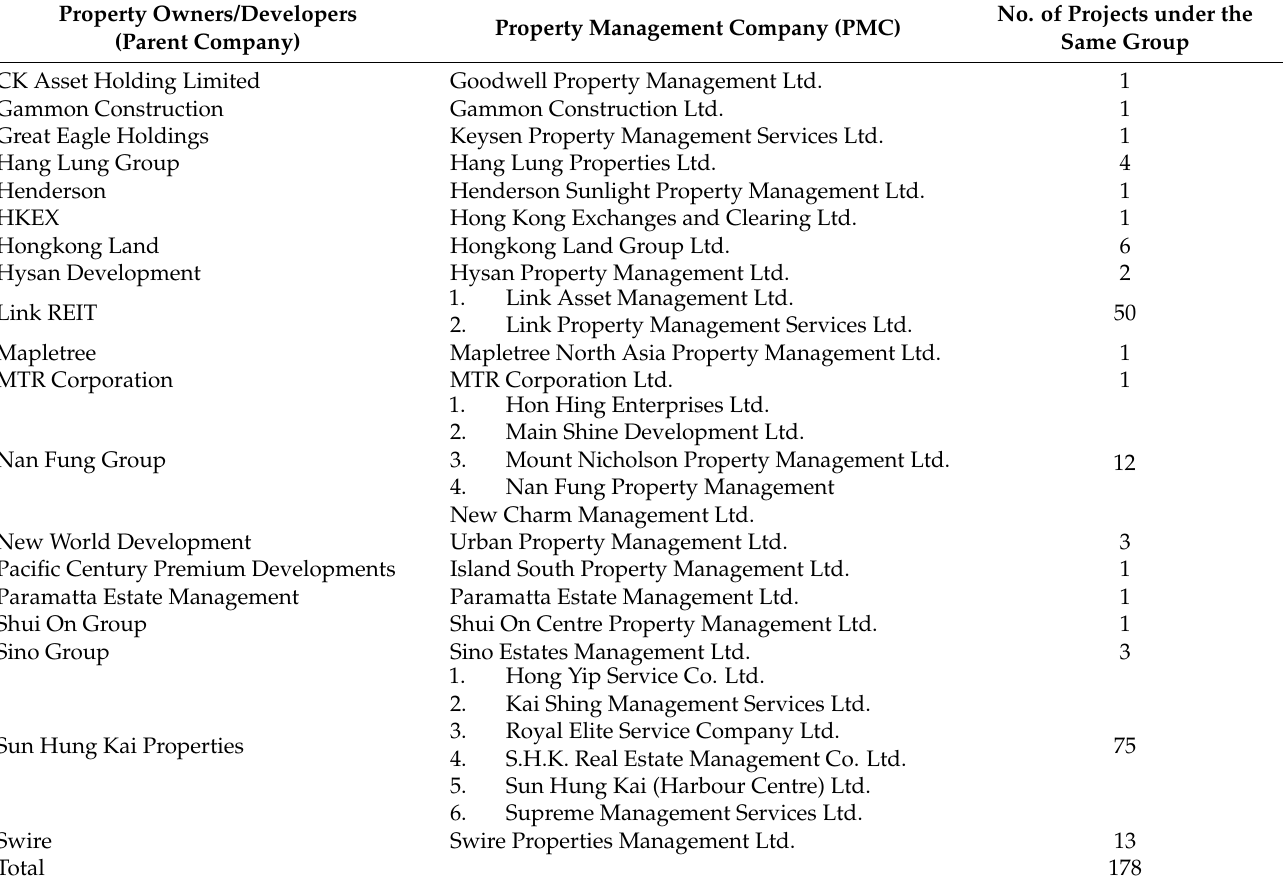
Table 5. Reciprocal relationships between developers and property management